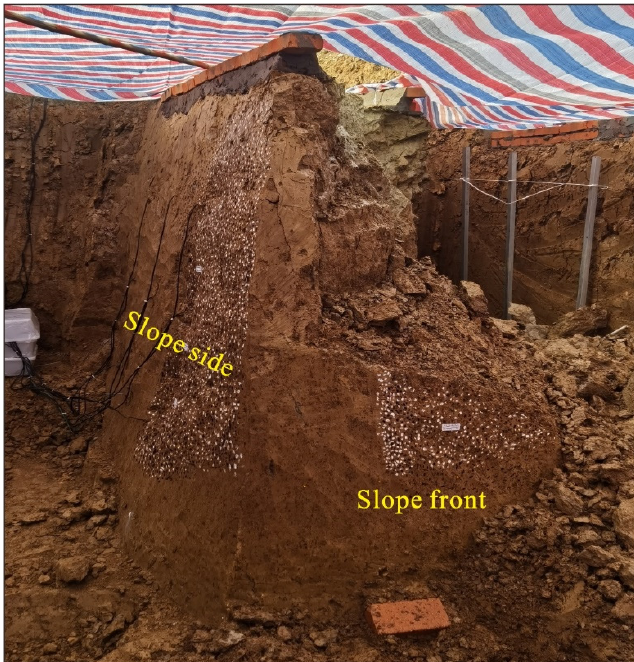
Figure 12. Shape of the slope after failure.